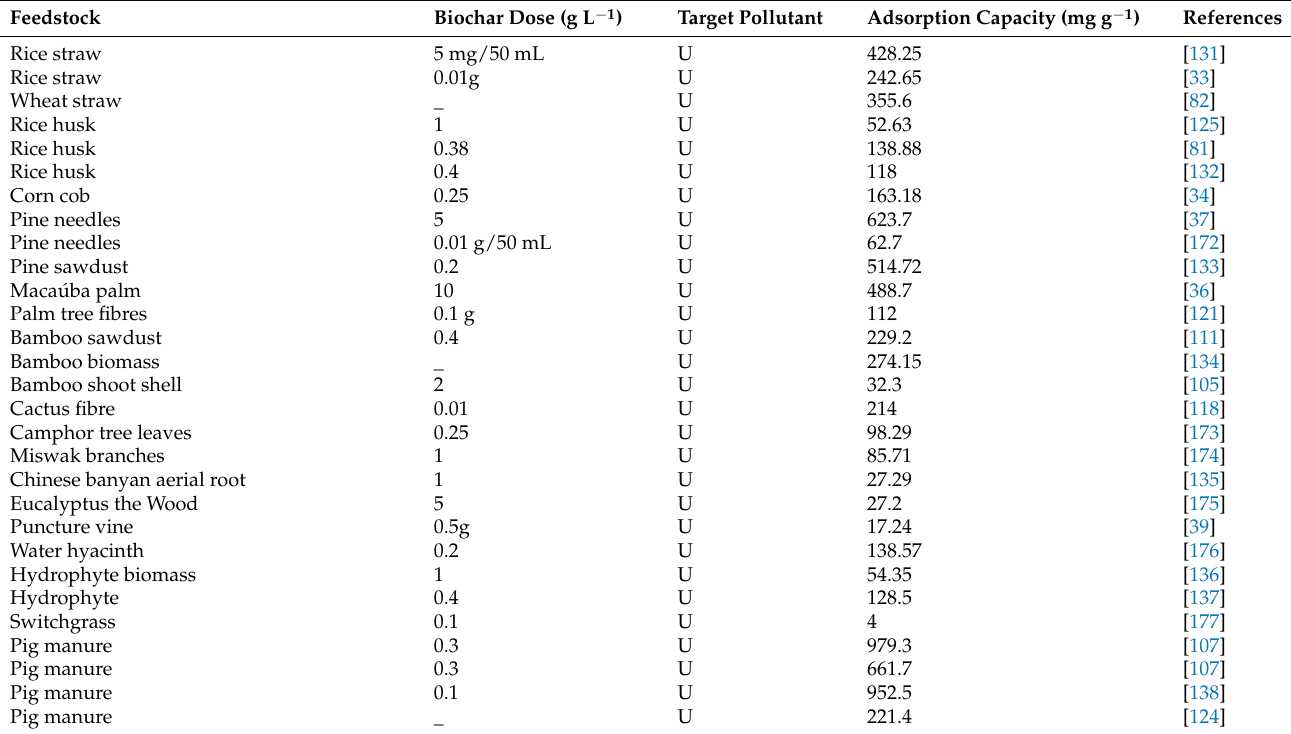
Table 4. Effect of biochar dosage on U and F −